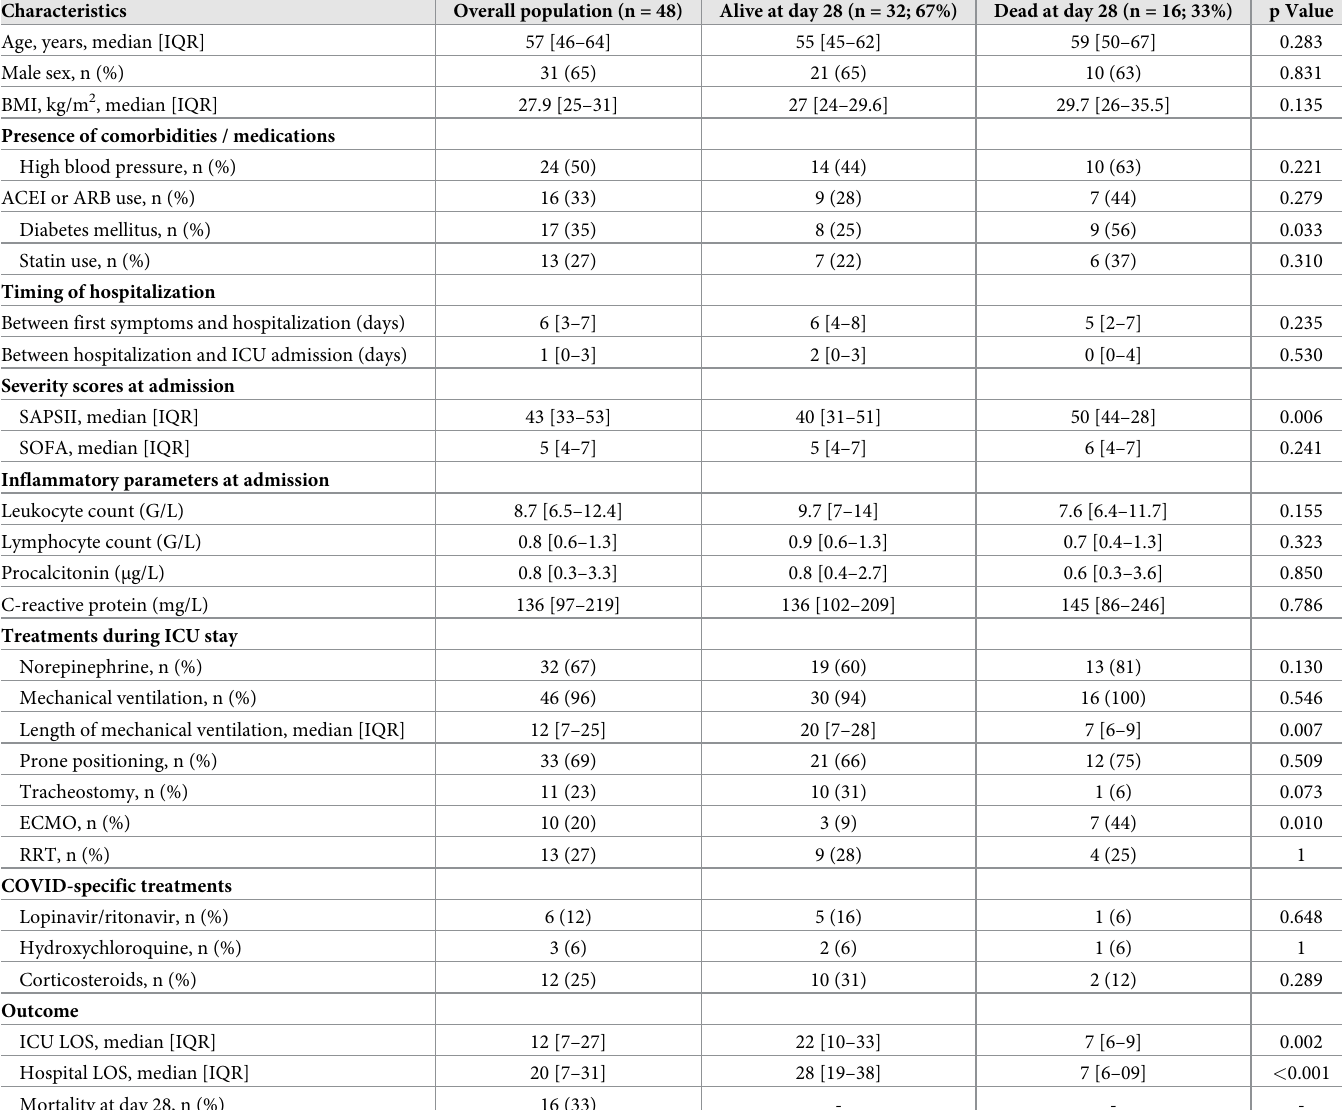
Table 1. General characteristics and outcome of the